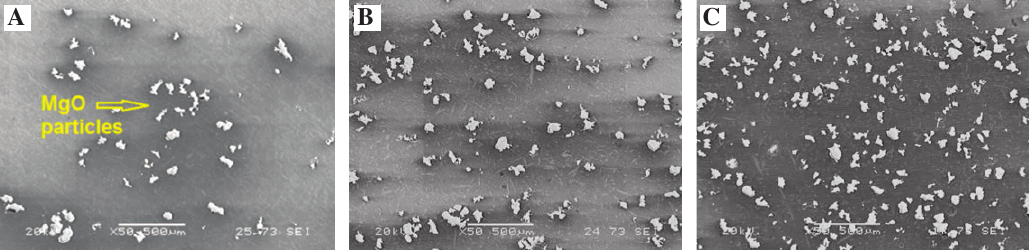
Figure 3 Microstructural images of composite specimens by SEM. (A) 5%, MgO, (B) 10%, MgO, (C) 15%, MgO (JEOL JSM-6060 LV, Scanning Electron Microscope,